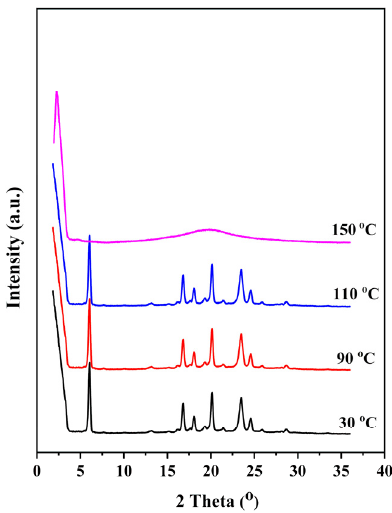
Figure 2. One-dimensional wide-angle X-ray diffraction (1D WAXD) pattens of M1 during heating process.